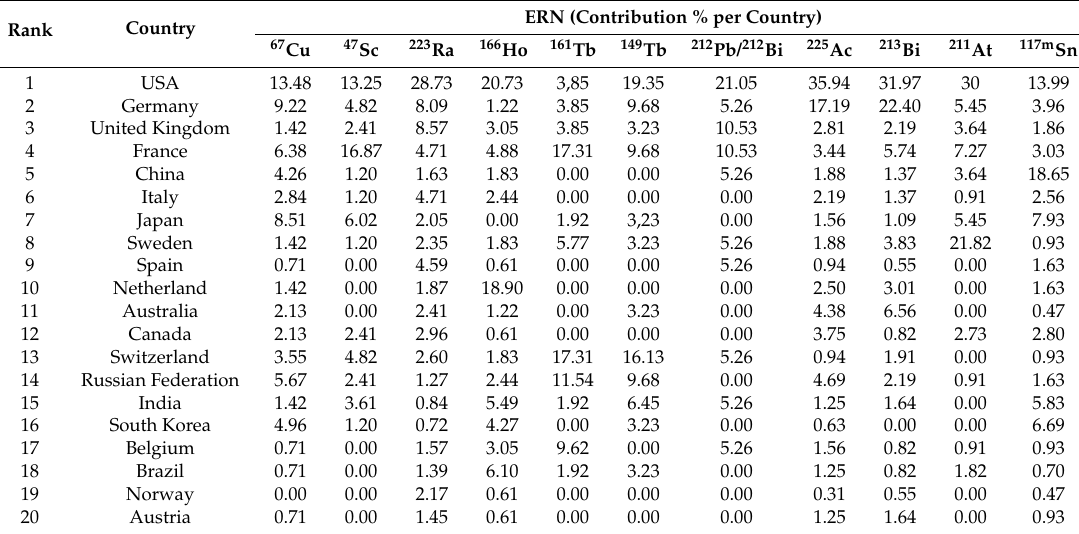
Table 9. Analysis of the popularity of different emergent radionuclides by the top 20 countries with the highest number of relevant publications (2008–2018). Highlighted in grey are the two highest percentages for each emergent radionuclide.